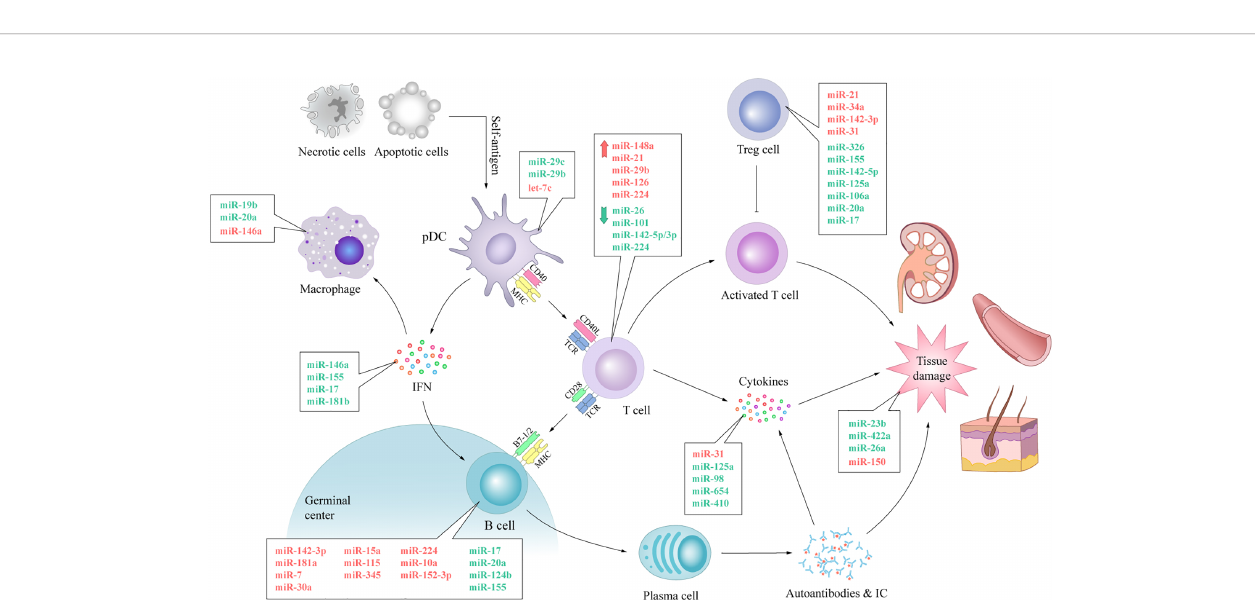
FIGURE 3 | Molecular mechanisms by which miRNAs promote B cell hyperactivity in SLE patients. These aberrant expressed miRNAs promote B cells abnormal activation and autoantibodies production in SLE by affecting important protein molecules in the B cell signaling pathway. MiR-15a interacts the Bcl-2 gene directly, which leads to the decrease of Bcl-2 and activation of intrinsic apoptotic pathway of regulatory B-10 cells. MiR-7 mediates the suppression of PTEN/AKT signaling, and then promotes B cell differentiation into plasma cells and spontaneous germinal center formation. Decreasing miR-155 in B cells contributes to the SHIP-1 reduction, which leads to the production of serum IgG anti-dsDNA antibodies. MiR-155 also suppresses PU.1 and TNF- a , and then inhibits BAFF and CD19 protein expression, and promotes the B cell proliferation and antibody production in SLE. MiR-30a increases in B cells of SLE patients and directly decreases the expression of Lyn, an important mediator of B cell activation, via targeting with the 3 ’ -UTR of Lyn mRNA. MOMP, Mitochondrial outer membrane permeabilization; BAX/BAK, Bcl-2-associated X protein/Bcl-2 homologous antagonist